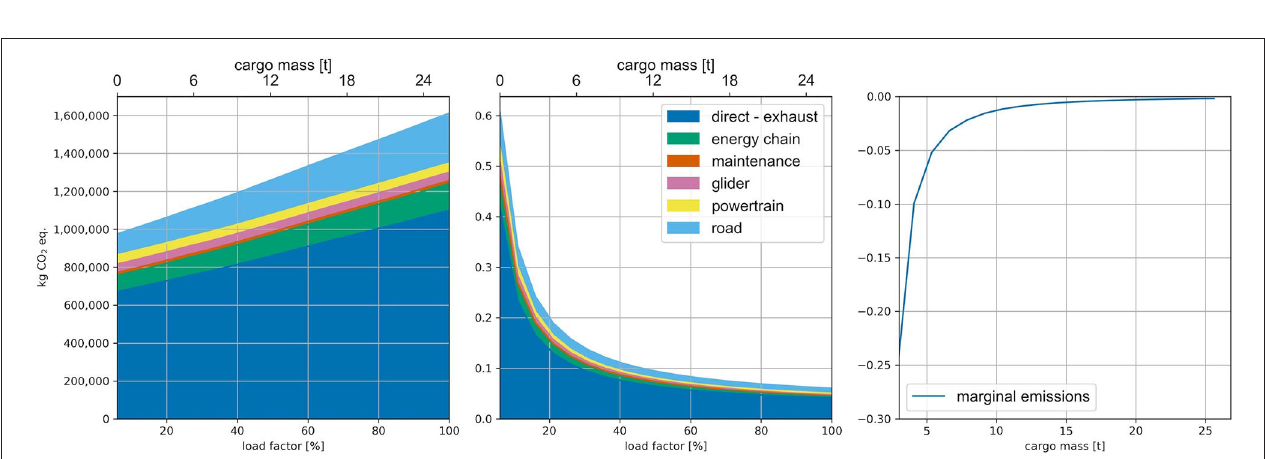
FIGURE 3 | Effect of efficiency improvements at database scale. The effect is obtained by randomly modifying the efficiency of all transformation activity datasets in the ecoinvent database and calculating the global warming impact for 50 randomly selected market activities. The effect is expressed as the ratio between the impact calculated using the improved datasets and the impact calculated using the unmodified dataset: values closer to 1 indicate a weaker effect. The efficiency improvement is performed on both the technosphere and biosphere matrices and the values of the efficiency improvement are randomly selected using a uniform and beta distribution, respectively, and in both the cut-off and consequential system models of the ecoinvent database.